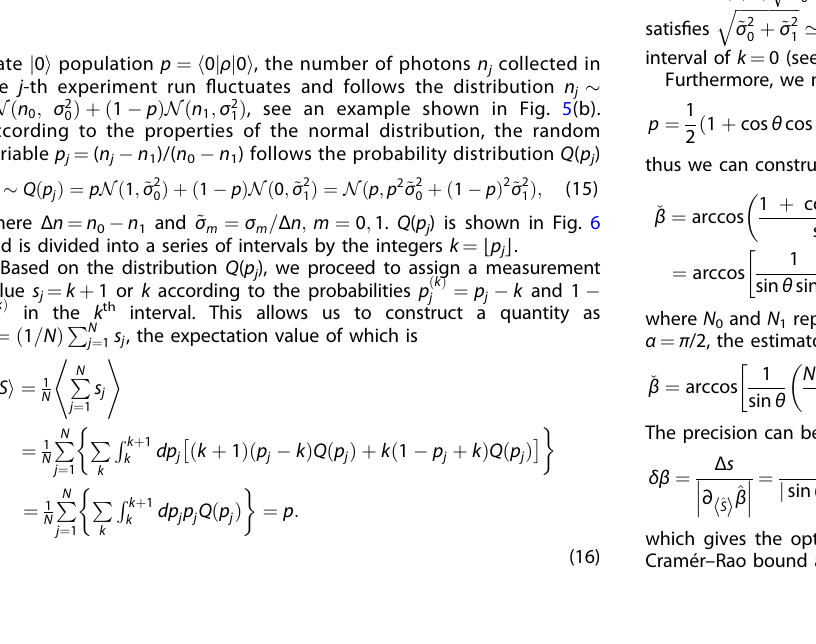
Fig. 6 Probability distribution. The probability distribution Q ( p j ) is divided into a series of intervals by k = ⌊ p j ⌋